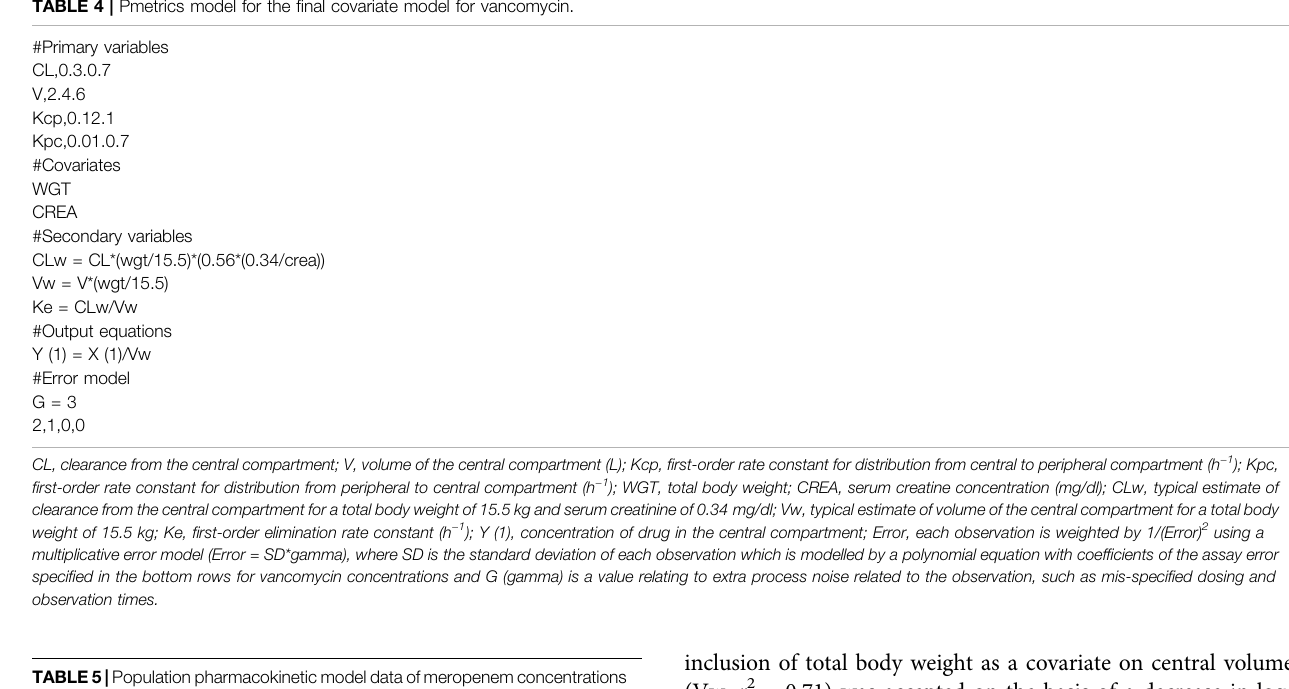
TABLE5| Populationpharmacokineticmodeldataofmeropenemconcentrations of paediatric patients undergoing extracorporeal membrane oxygenation. PK parameter